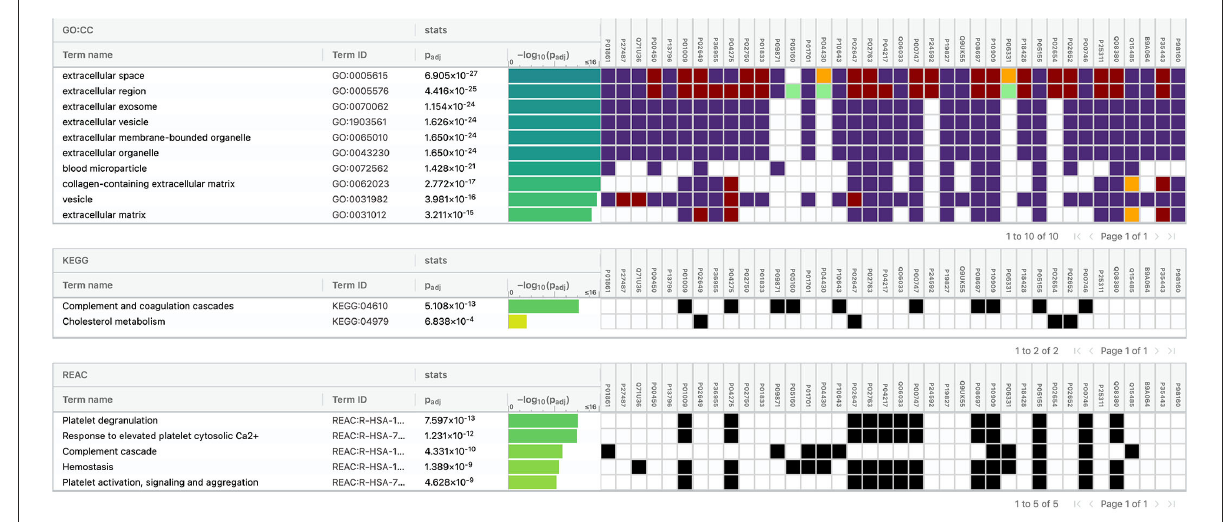
FIGURE10 Functional enrichment analysis of differentially expressed proteins between intracerebral hemorrhage and healthy